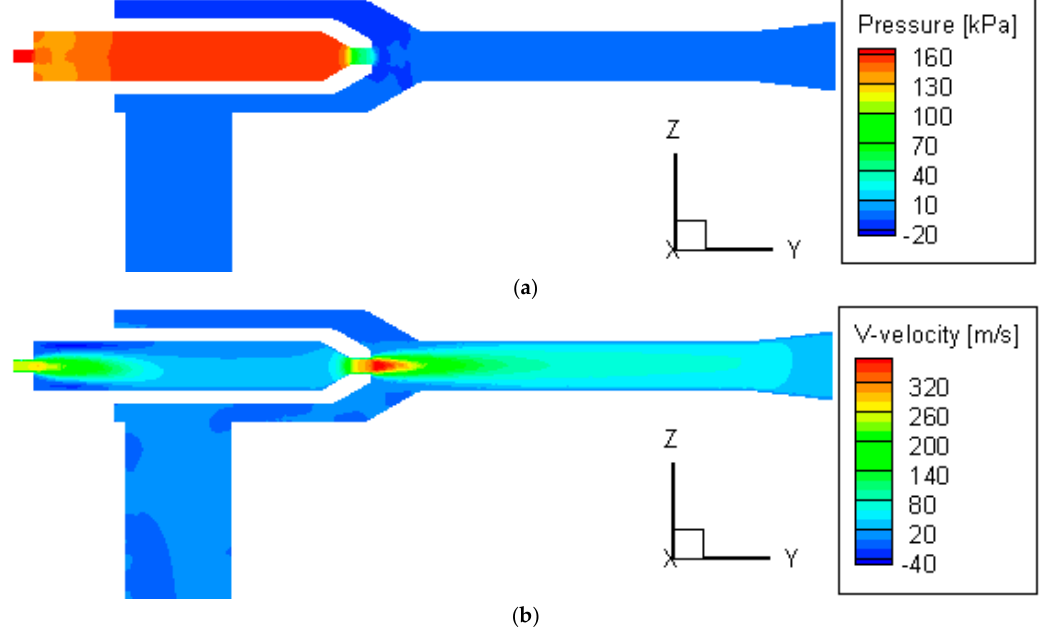
Figure 12. Cross-sectional static pressure and velocity distributions: ( a ) static pressure; ( b ) axial velocity.